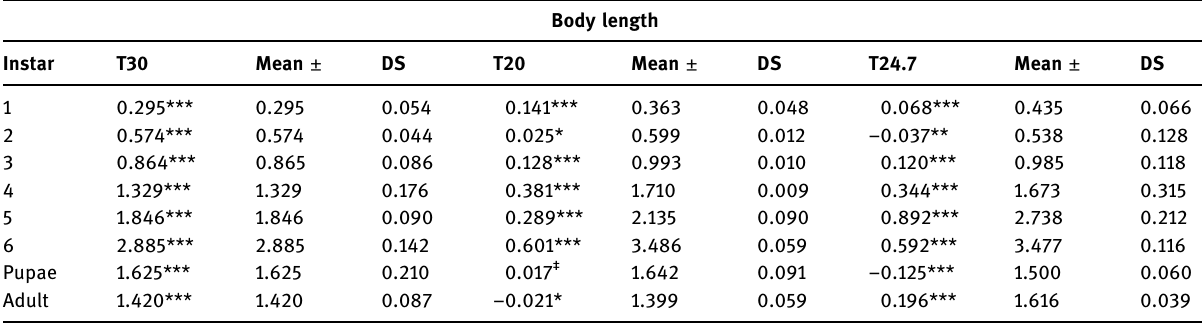
Table 4: Body length ( mm ) of D. busckella larvae at di ff erent developmental stages under three di ff erent temperatures under controlled conditions